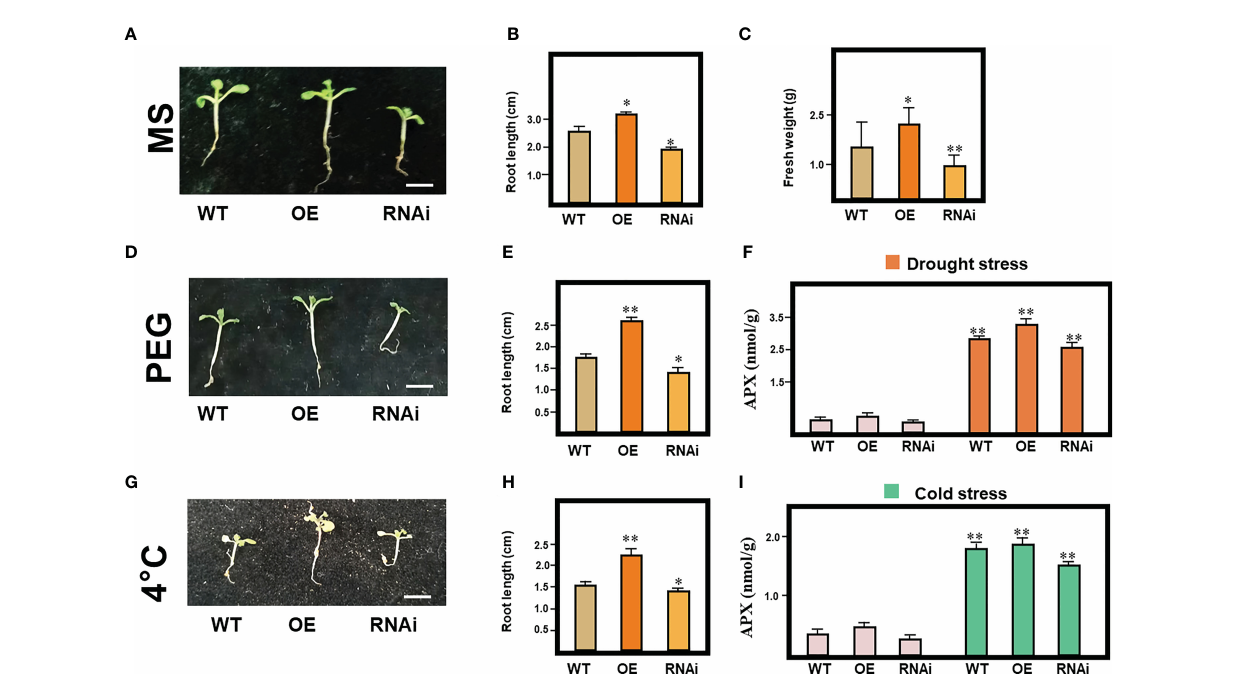
FIGURE 6 MrbHLH10 expression in response to drought and cold stress. (A) Time course of MrbHLH10 expression in A . thaliana exposed to drought and cold stress on standard ½ MS medium. (B) Root length and (C) fresh weight of wild-type (WT), MrbHLH10 -OE and MrbHLH10 -RNAi lines grown on standard ½ MS medium for 1 weeks. (D) Time course of MrbHLH10 expression in A . thaliana exposed to drought stress on standard ½ MS medium with 8% PEG for 1 weeks. (E) Root length of wild-type (WT), MrbHLH10 -OE and MrbHLH10 -RNAi lines grown on standard ½ MS medium with 8% PEG for 1 weeks. (F) APX content in leaves of wild-type (WT), MrbHLH10 -OE and MrbHLH10 -RNAi lines grown on standard ½ MS medium with 8% PEG for 1 weeks. (G) Time course of MrbHLH10 expression in A . thaliana exposed to drought stress on standard ½ MS medium with 4 °C for 1 weeks. (H) Root length of wild-type (WT), MrbHLH10 -OE and MrbHLH10 -RNAi lines grown on standard ½ MS medium, with 4 °C for 1 weeks. (I) APX content of wild-type (WT), MrbHLH10 -OE and MrbHLH10 -RNAi lines grown on standard ½ MS medium, with 4 °C for 1 weeks. Data are presented as means ± SD (n = 3). (* P < 0.05, ** P < 0.01, Student ’ s